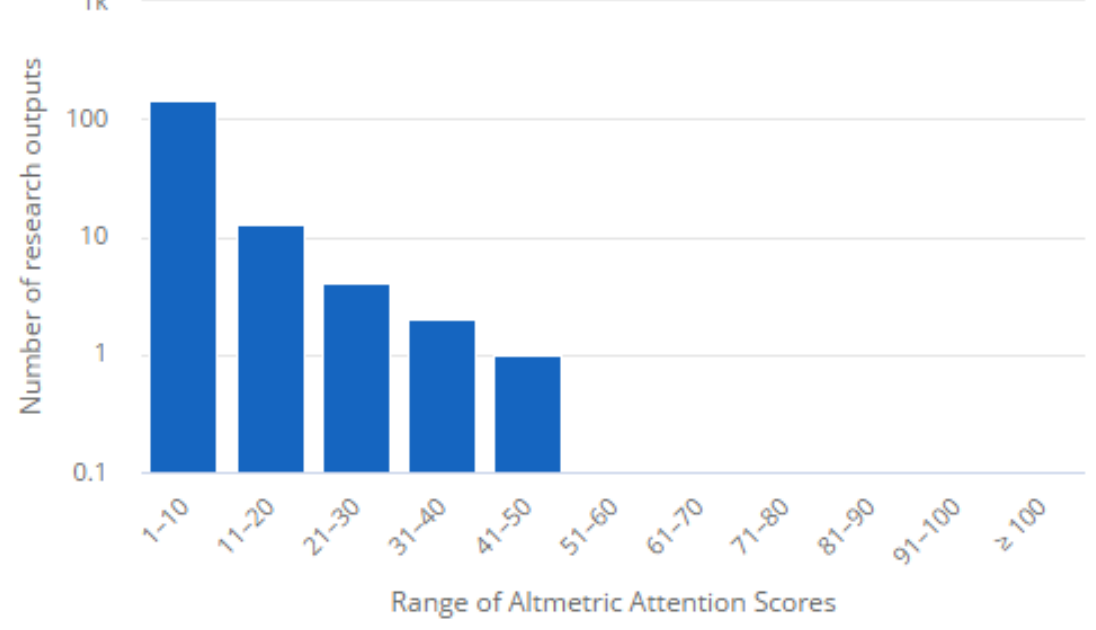
Figure 3. Distribution in altmetric attention scores related to environmental valuation research.